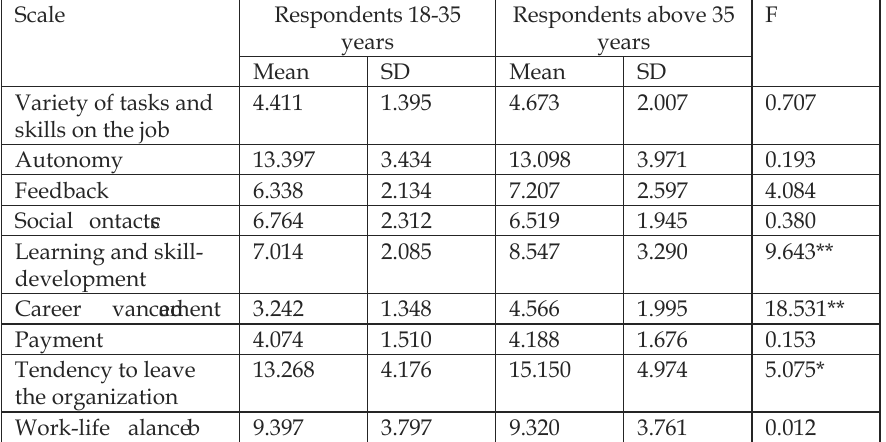
Tab. 5. One-way ANOVA for each scale per generation - means, standard deviation and